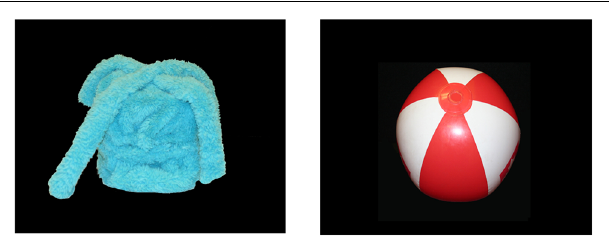
FIGURE 2 |Two pictures used in the word learning phase and the label comprehension phase. These pictures show a ball and the box target